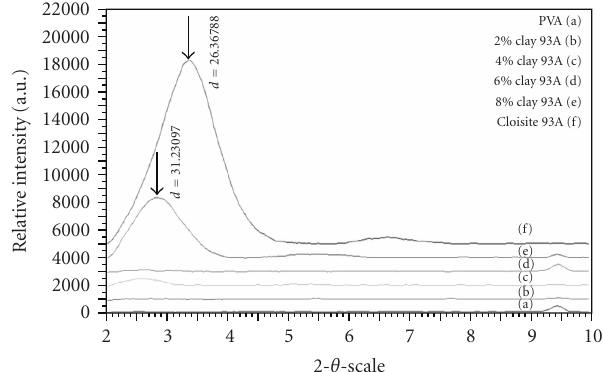
Figure 2: XRD patterns of sulfonated PVA membranes varying in concentration of Cloisite